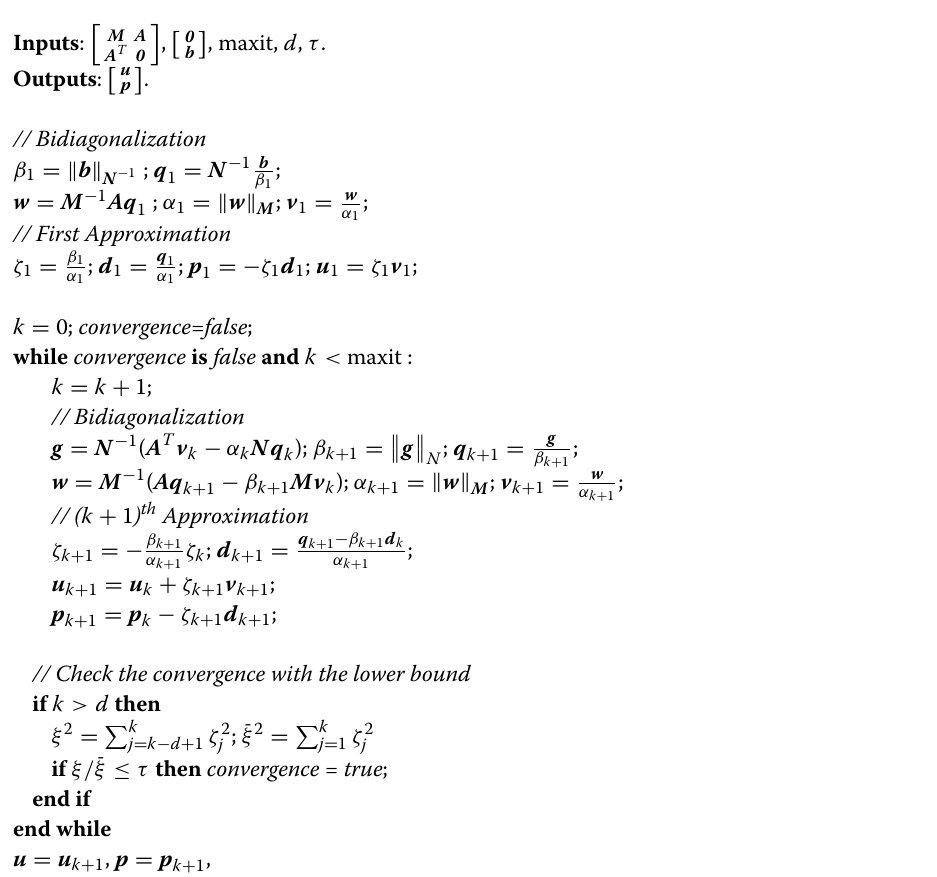
Algorithm 1 Generalized Golub-Kahan Bidigonalization, Craig’s